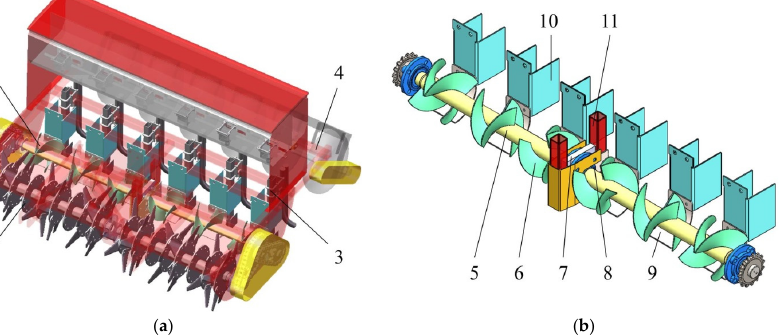
Figure 1. SSRSD with its specific position. ( a ) Installation position of SSRSD of wheat no-till planter; ( b ) the structure of SSRSD. Note: 1, SSM; 2, no-till anti-blocking knife; 3, furrowing opener; 4, frame; 5, spiral shaft; 6, RB; 7, spiral shaft positioning plate; 8, rolling bearing; 9, straw hopper; 10, straw baffle; 11, support-connecting frame.